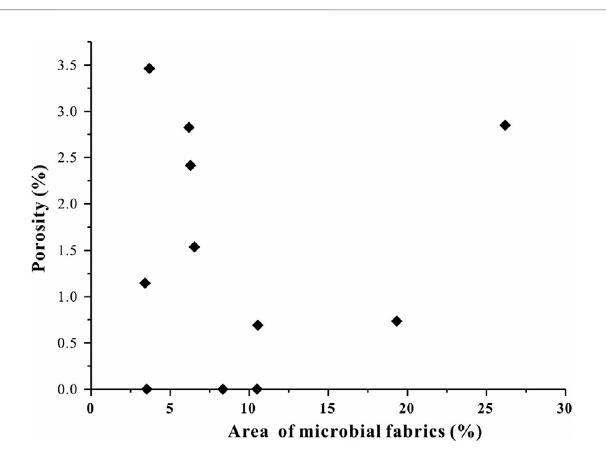
FIGURE 4 Cross plot of microbial fabric area and porosity in microbialits showing no